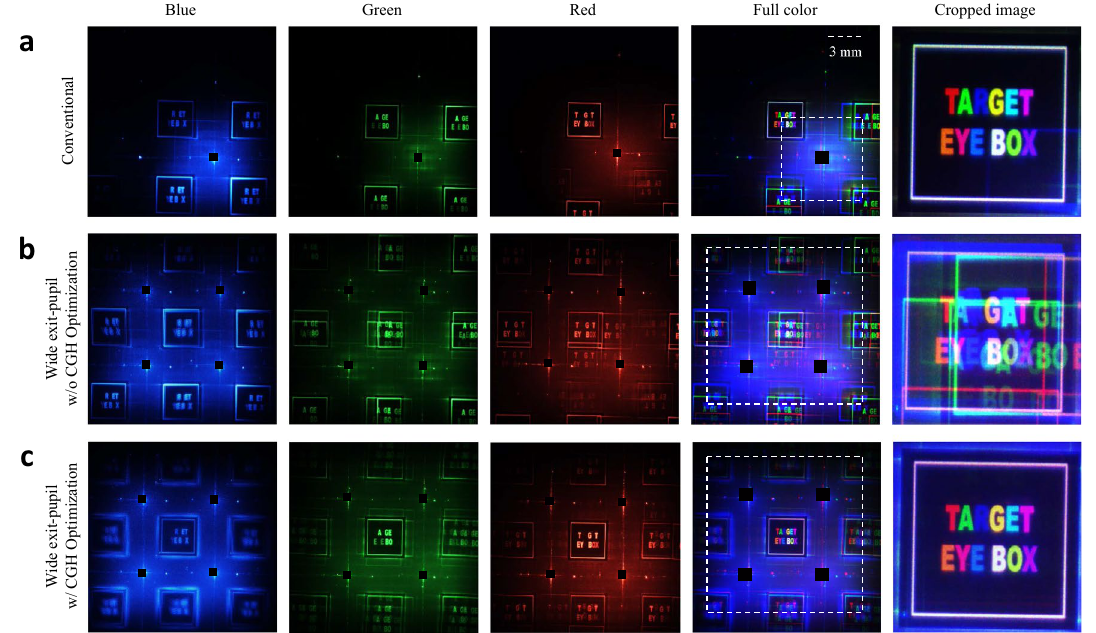
Figure 2. Fourier holograms reconstructed for eyebox visualization. ( a ) Reconstructed images from the conventional holographic near-eye display. Reconstructed images using proposed wide eyebox holographic near-eye display ( b ) with a conventional non-optimized CGH and ( c ) with an optimized CGH. The position and size of the region of interest are set to the center of the expanded exit-pupil and 3 mm × 3 mm,